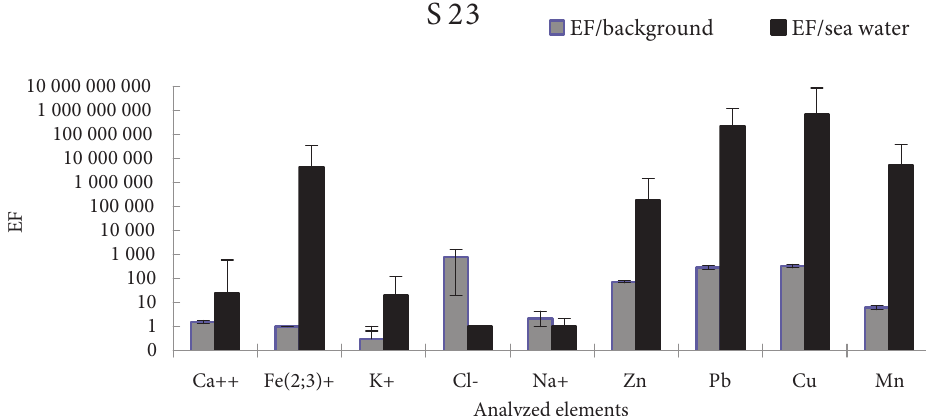
Figure 11. Enrichment factors of particle deposition constituents referred to Fe and Cl (for S23 site)